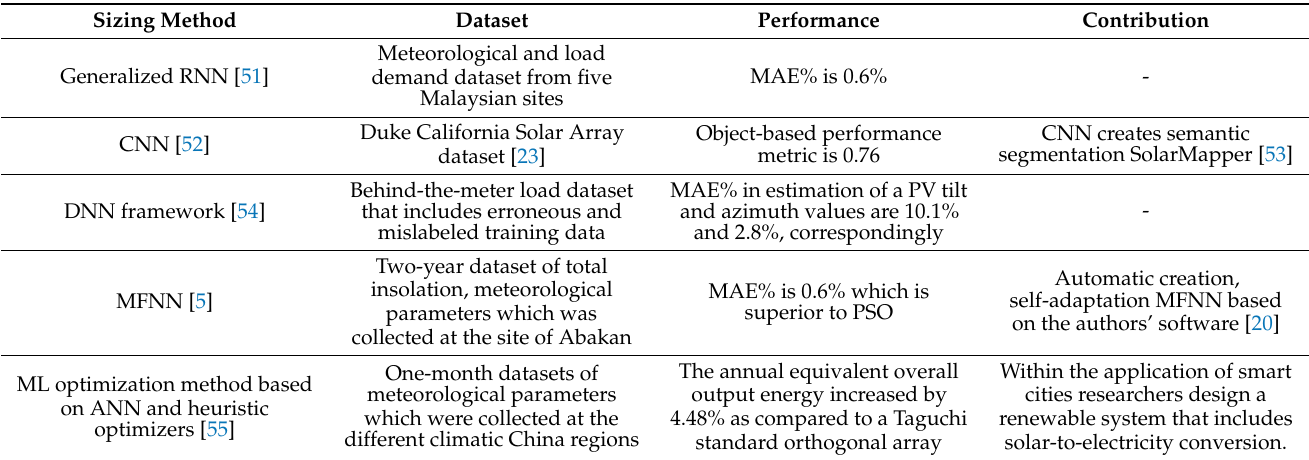
Table 6. Comparison of ML sizing